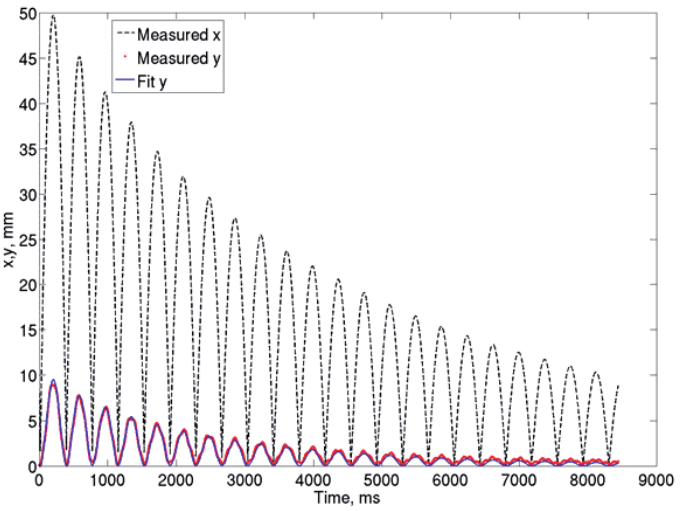
Fig. 4 X - and y positions of the sphere versus